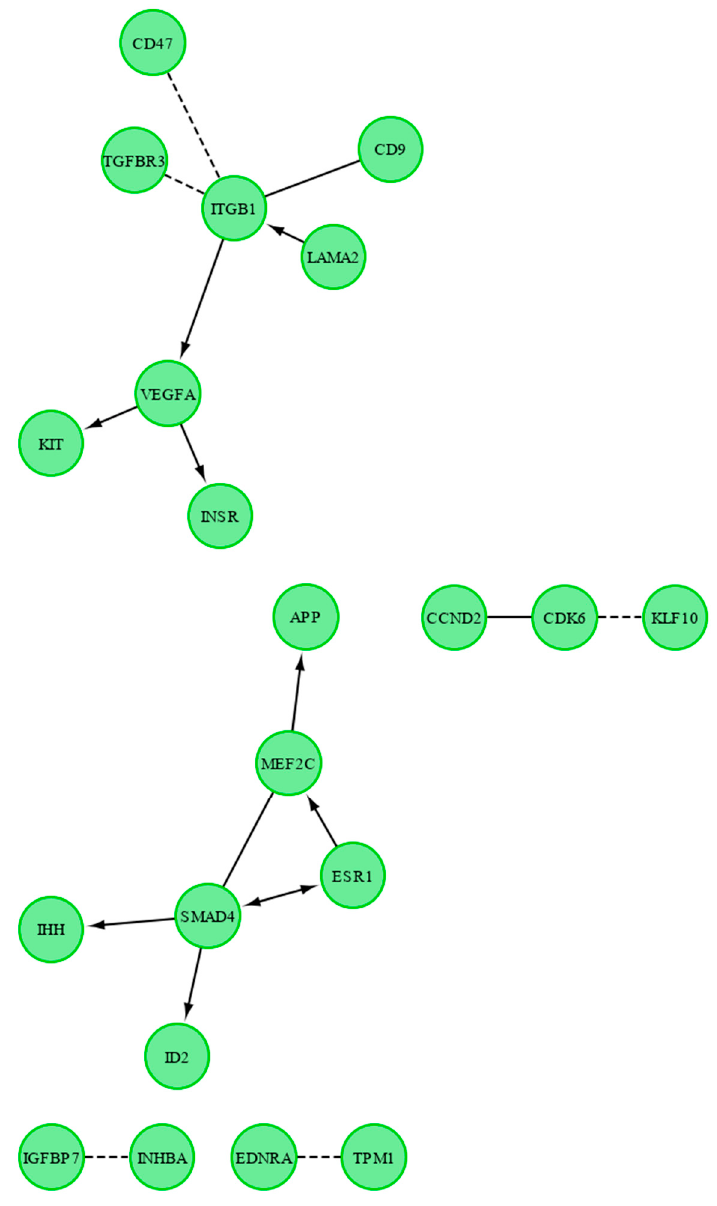
Figure 6. Functional interaction (FI) between the analyzed downregulated genes that belong to the “cell proliferation”, “regulation of programmed cell death”, and “regulation of cell migration”. In the following figure “->“ stands for activating/catalyzing, “-|” for inhibition, “-” for FIs extracted from complexes or inputs, and “---” for predicted FIs.